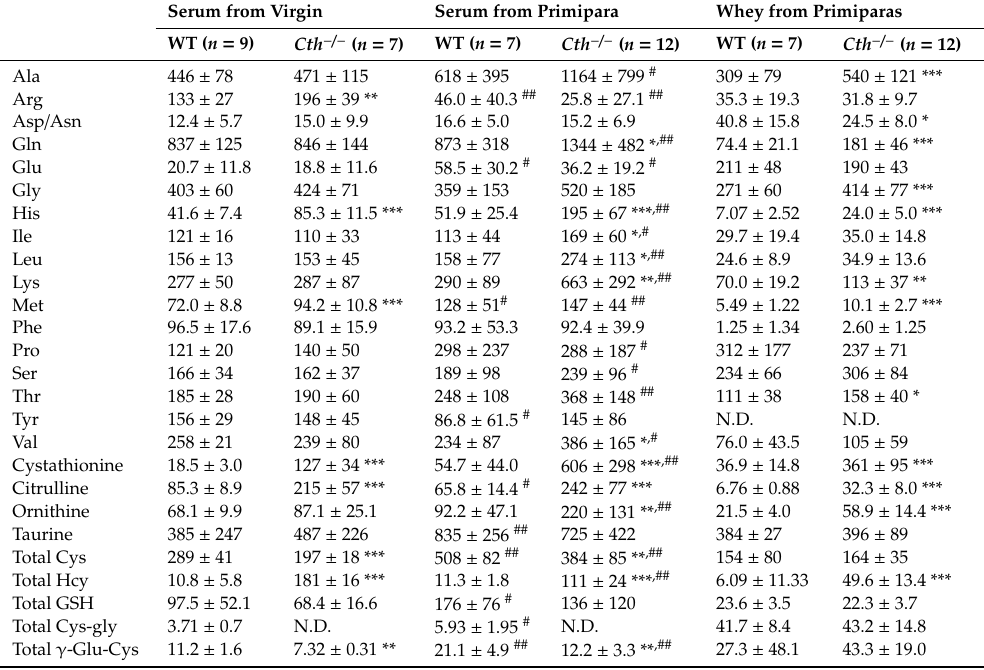
Table 1. Amino acid levels in serum and whey from virgin and primipara (with 2-week-old pups) of wild-type and Cth − / − mice.